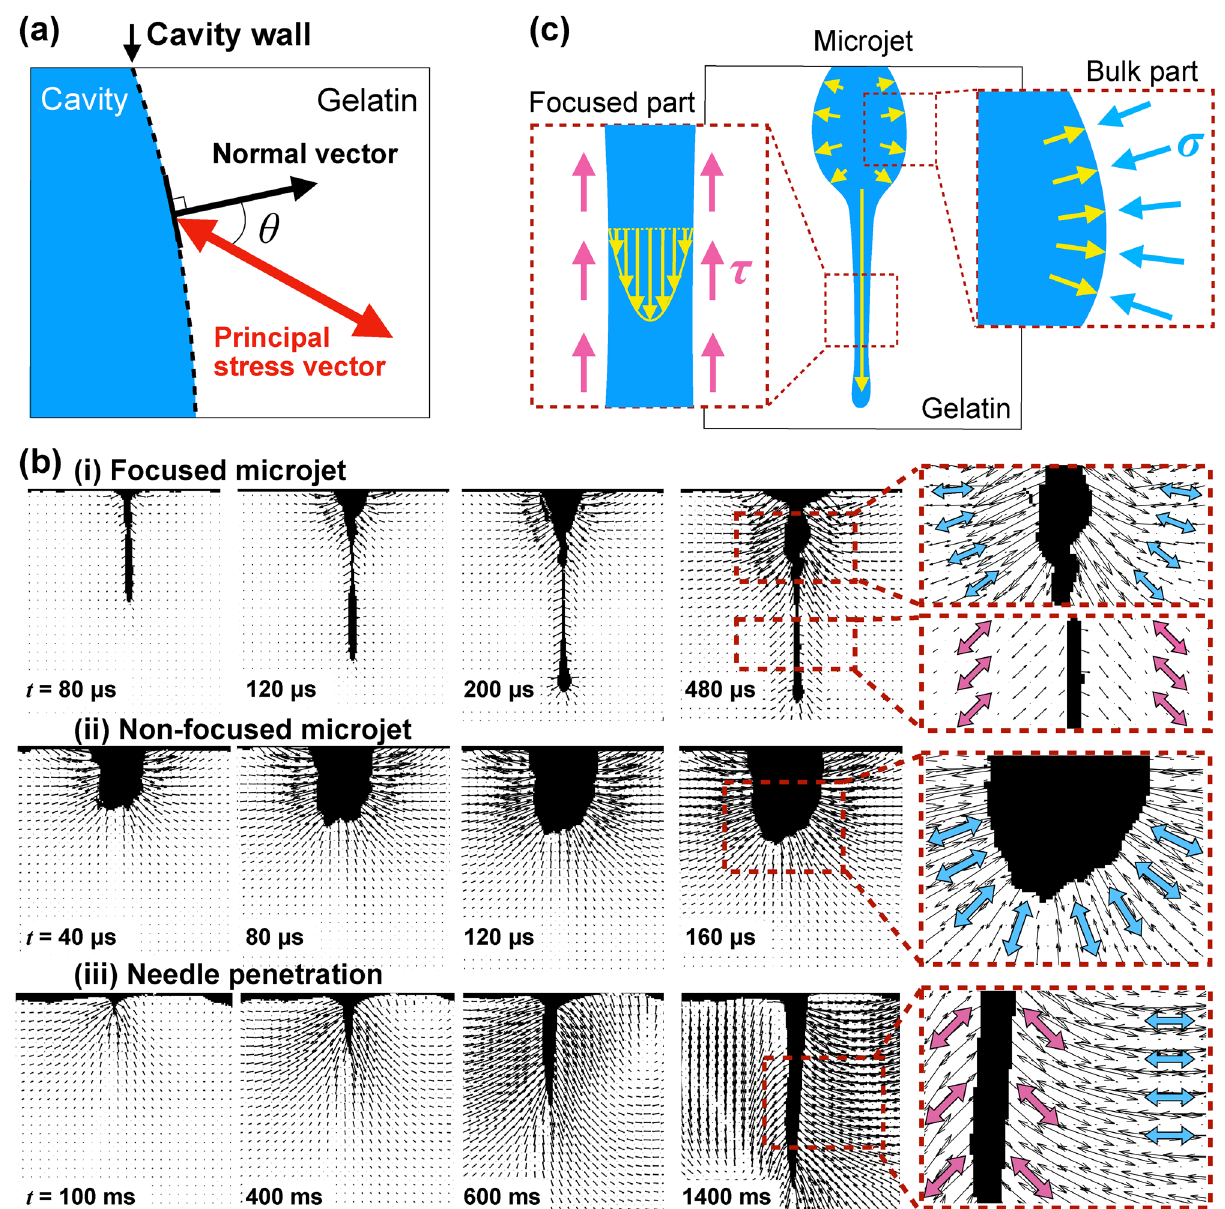
vectors is related to the flow direction of the